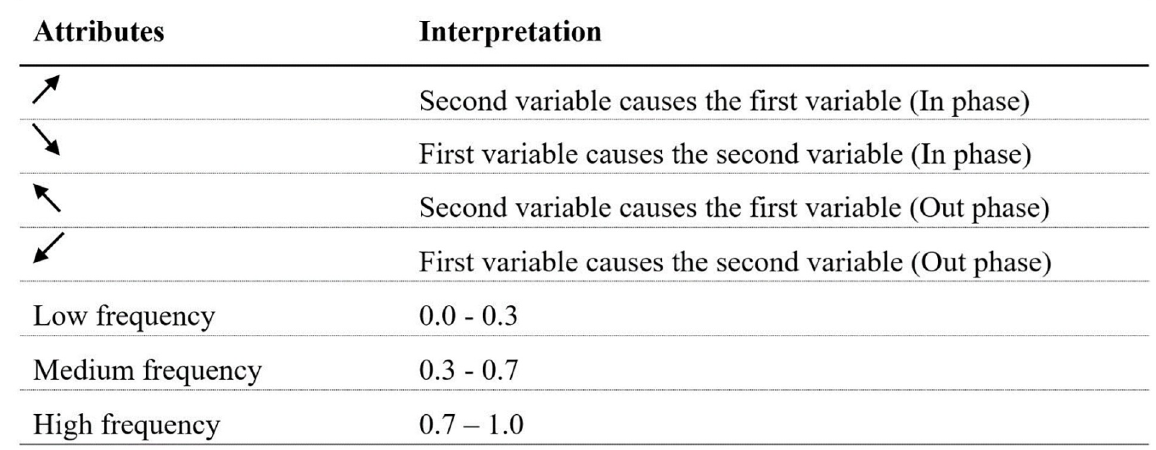
Fig 3. Interpretation of wavelet coherence. Sources: Authors’ compilation.